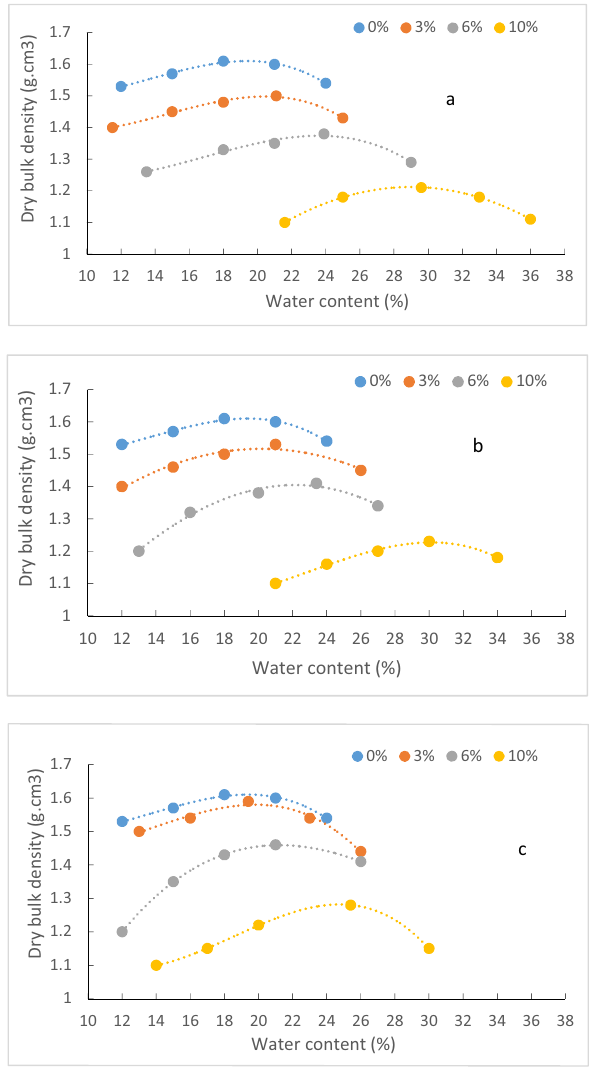
Figure 4: Proctor compaction test curves of the nano TiO 2 - treated soil studied. ( a ) 5 – 10 nm, ( b ) 20 – 30 nm, ( c ) 90 – 110 nm.